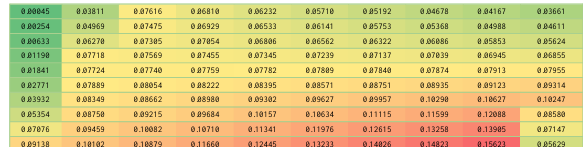
Table 2. Maximum distances of the fitting straight lines on the right image of the IKONOS dataset (pixel) Table 3 indicates that the curvatures of epipolar curves, corresponding to 100 evenly distributed points on the right image are also similar. The maximum value is 75.49093 degrees, and